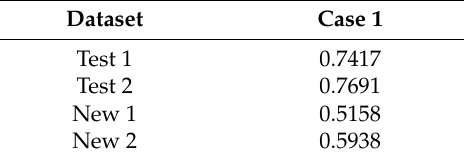
Table 5. Recall of building